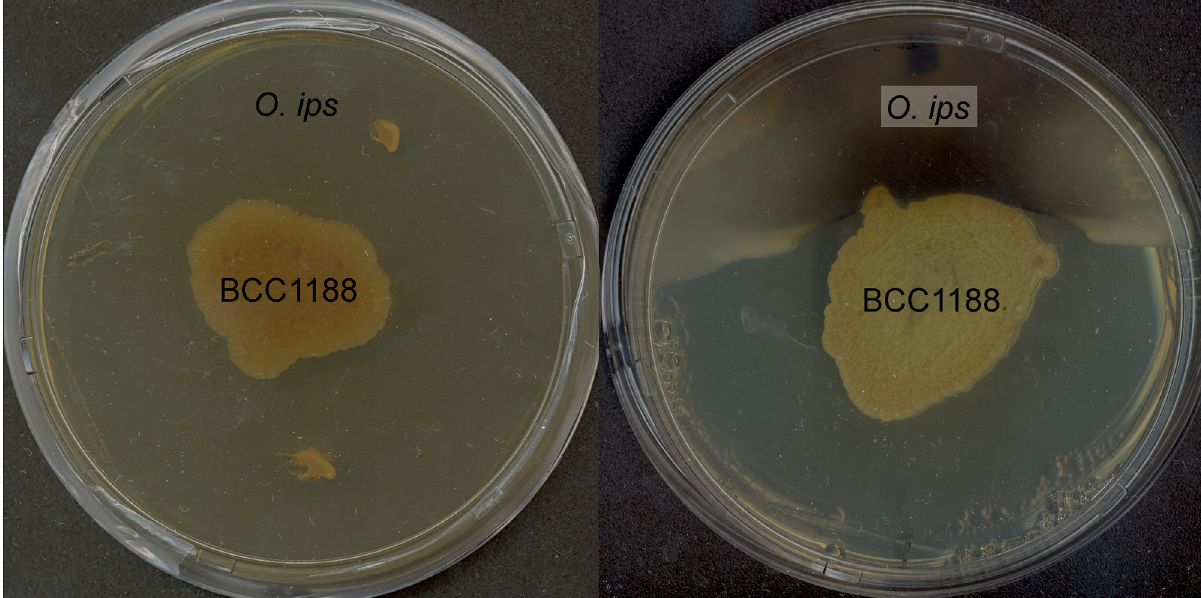
Figure 3: Bioassay challenge with isolate BBC1188 and Ophiostoma ips simultaneously inoculated (right) and bacteria inoculated 2 weeks before fungi (left) on yeast malt extract agar. This figure illustrates how a fungal isolate can grow uninhibited with a bacterial culture when inoculated at the same